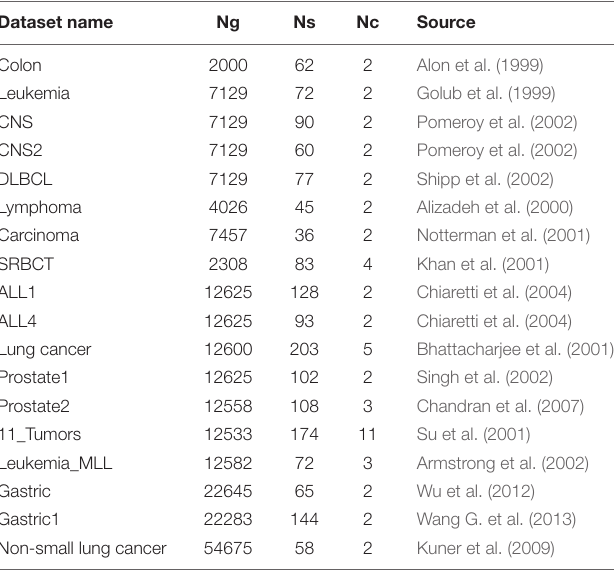
TABLE 1 | Descriptions of